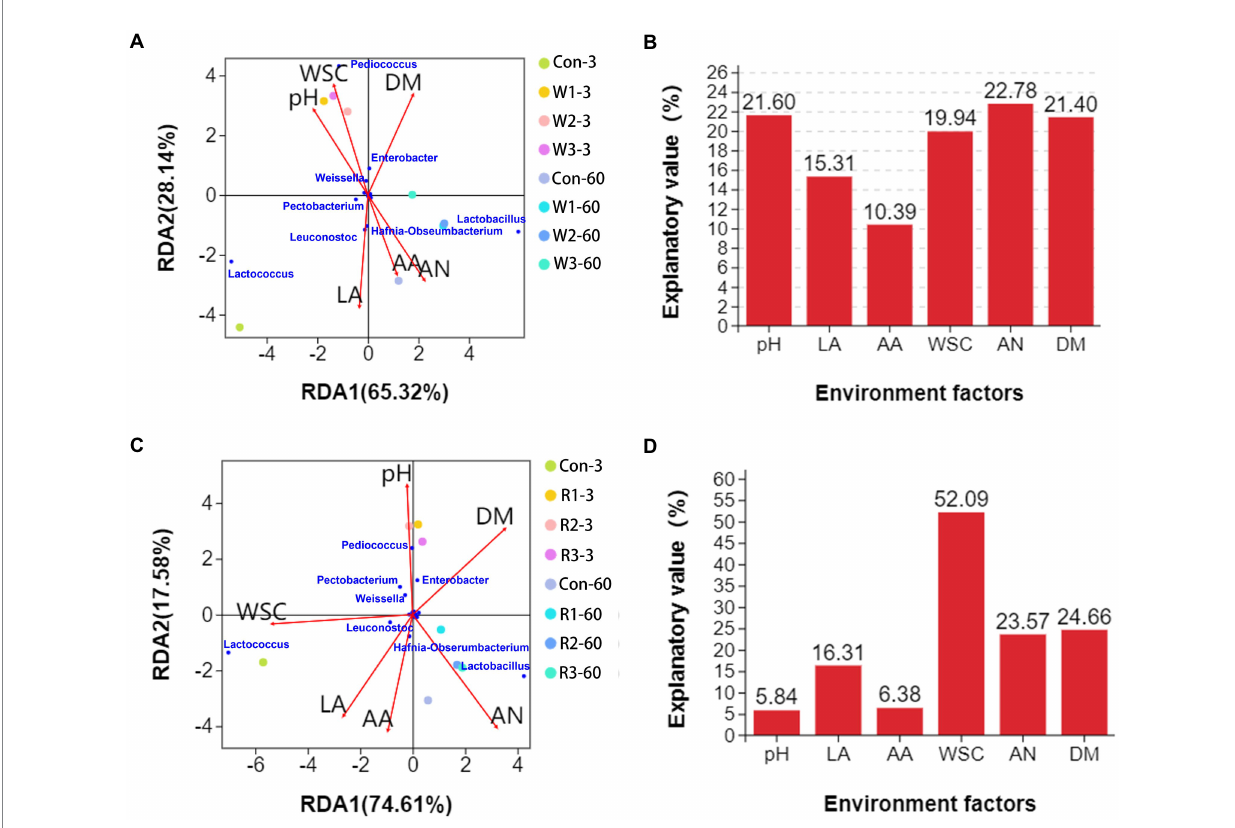
FIGURE 7 RDA of environmental factors, samples and bacterial genera in Chinese cabbage waste anaerobically fermented with wheat bran (A) or with rice bran (C) . VPA of the microflora explained by the environmental factors in Chinese cabbage waste anaerobically fermented with wheat bran (B) or rice bran (D) . The control group (Con). Chinese cabbage waste was mixed with wheat bran at a mass ratio of 383:117 (W1), 353:147 (W2), and 323:177 (W3) or with rice bran at 387:113 (R1), 358:142 (R2), and 329:171 (R3), respectively; 3 and 60 mean day 3 and day 60, respectively; DM, dry matter; LA, lactic acid; AA, acetic acid; AN, ammonia-N; WSC, water-soluble